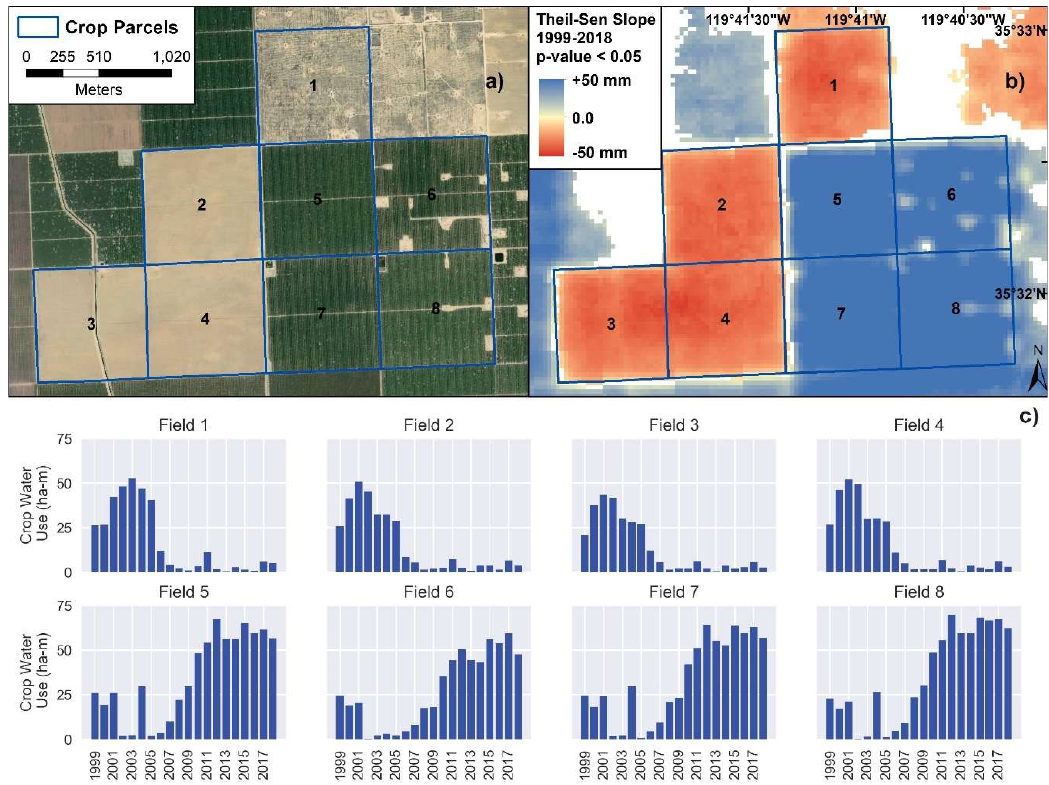
Figure 7. Eight crop parcels that are identified as cotton fields in 1999–2003 but fields 1–4 transition to uncultivated agriculture and parcels 5–8 transition to almonds. Graphic shows ( a ) the current Google Earth imagery for the selected parcels, ( b ) the statistically significant pixels of the 1999–2018 Theil–Sen slope (blue indicates increasing slope and red indicated decreasing slope), and c the total water use for each of eight fields from 1999 to 2018.